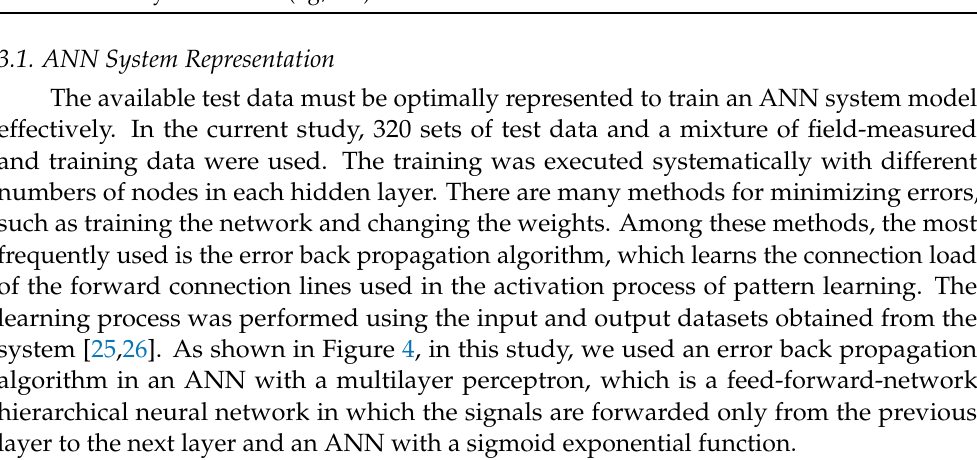
Table 4. Neural network performance based on training results. Number of Neurons